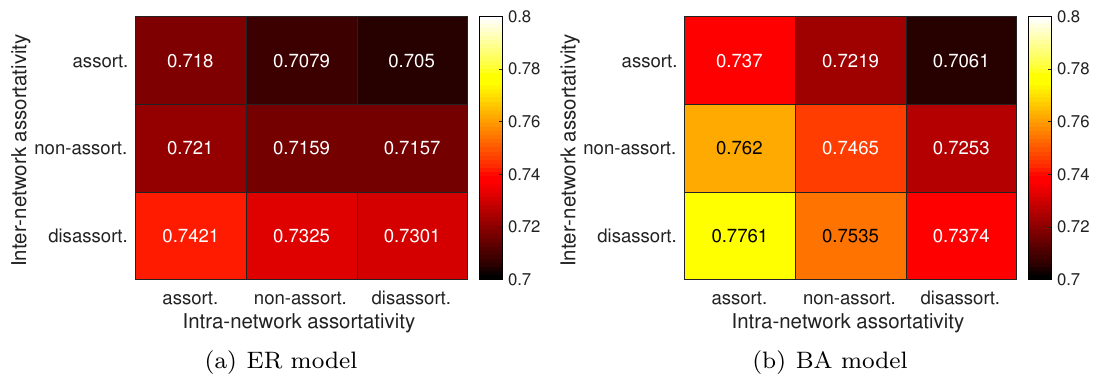
Figure 6. GCS with changes in assortativity. The results are represented as heat maps. The GCS denotes the size of the largest connected component, and thus higher values indicate high performance (bright